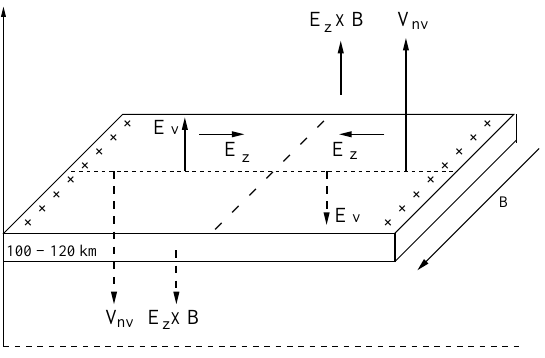
Fig. 2. Schematic diagram showing the effect of vertical wind on sporadic-E ion layer. Here V nv represents the vertical wind. E z and E v are zonal and vertical fields respectively